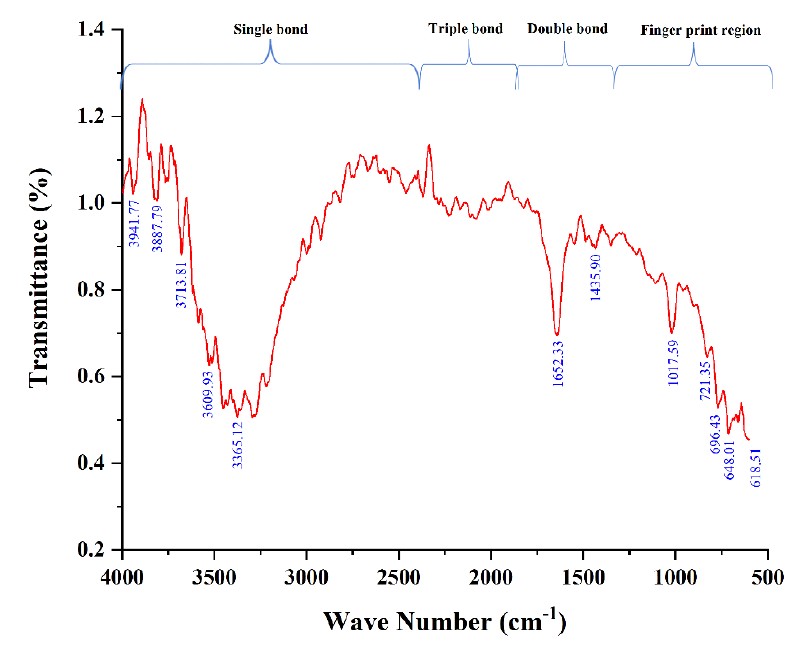
Figure 1. FTIR spectra of the C. orchioides A.L. extract.